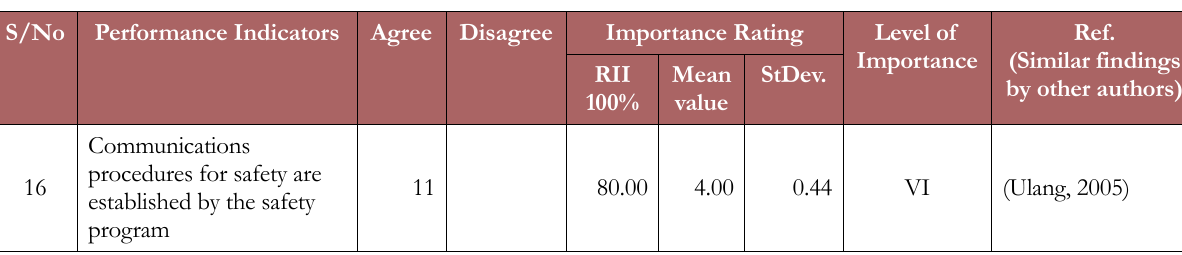
Table 3. Key Performance Indicators for the communication & maintenance of effective safety